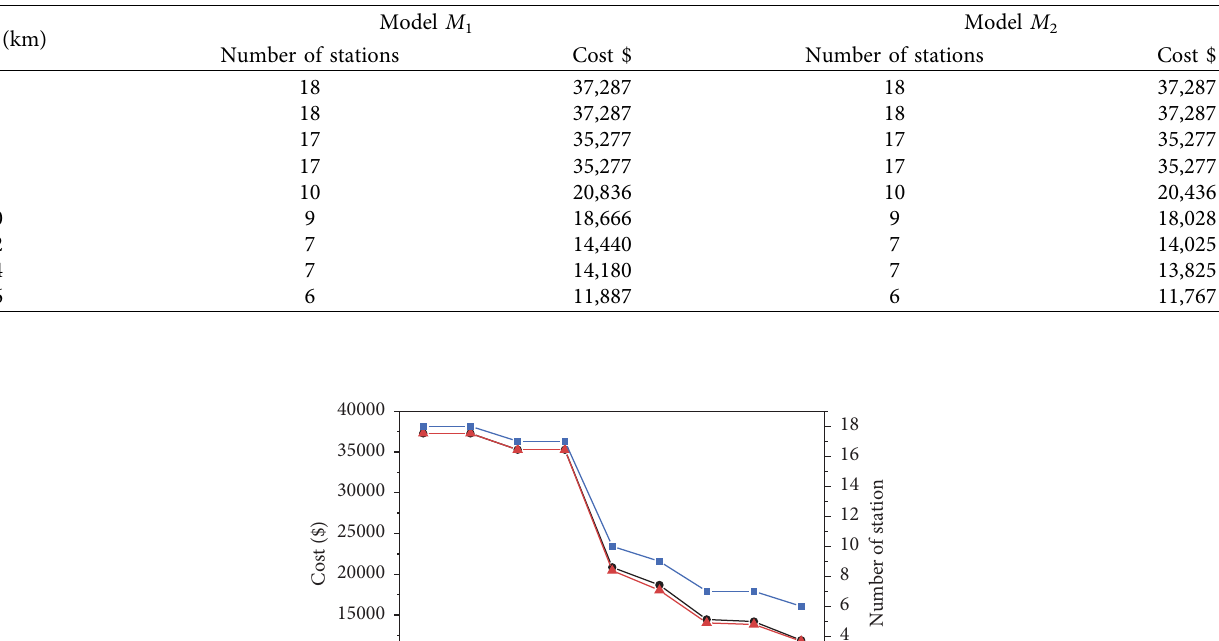
Table 3: Te impact of the coverage radius on the results of models M